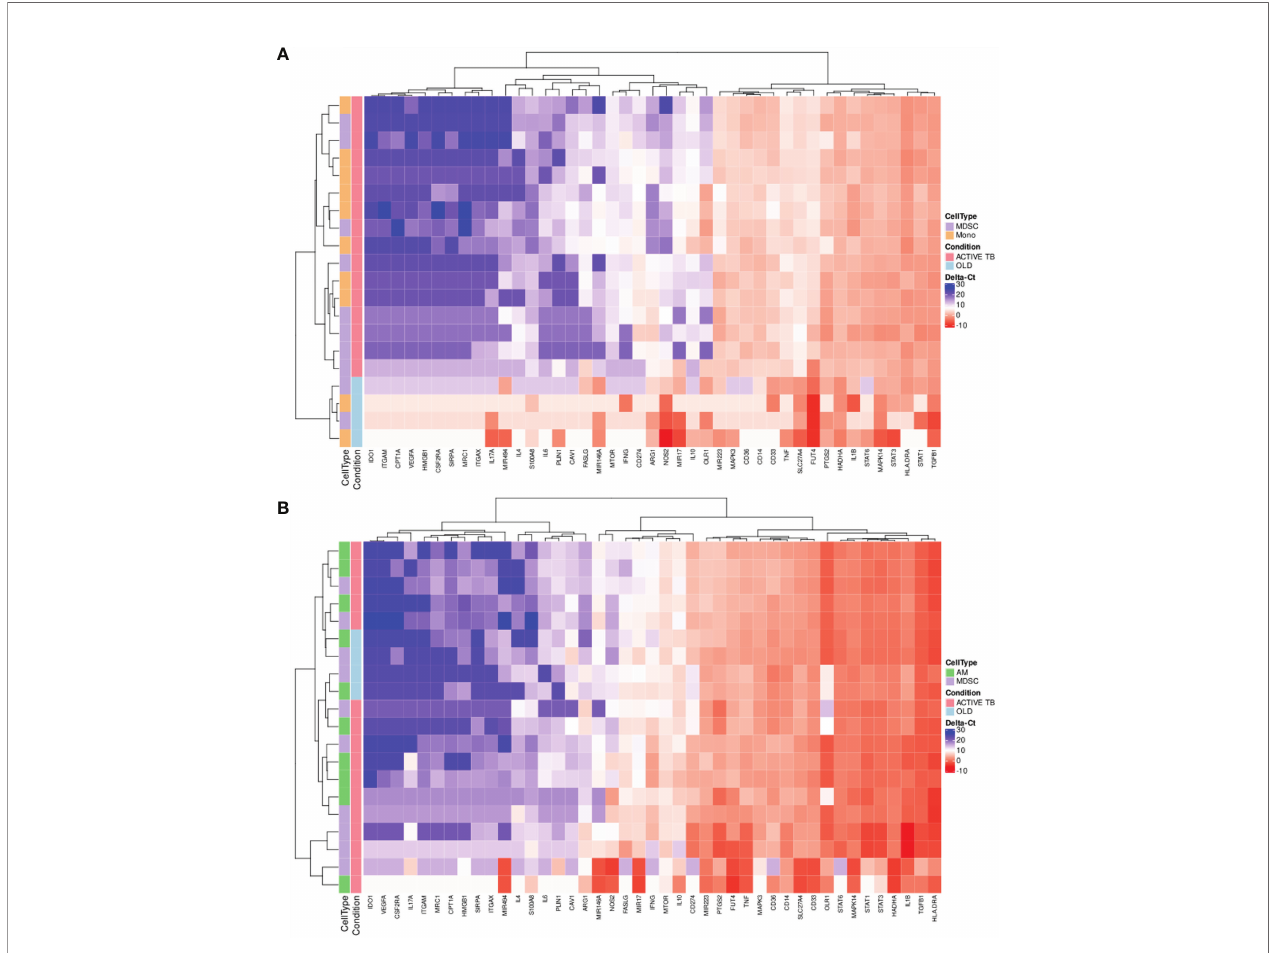
FIGURE 2 | Scaled gene expression patterns of (A) MDSC and monocytes in PB (16x pre-ampli fi cation), and (B) MDSC and AM in BALF (16x pre-ampli fi cation). Lower expression (higher D Ct-values) is indicated by blue. Hierarchical clustering of similar expression patterns across subject and genes is indicated by the